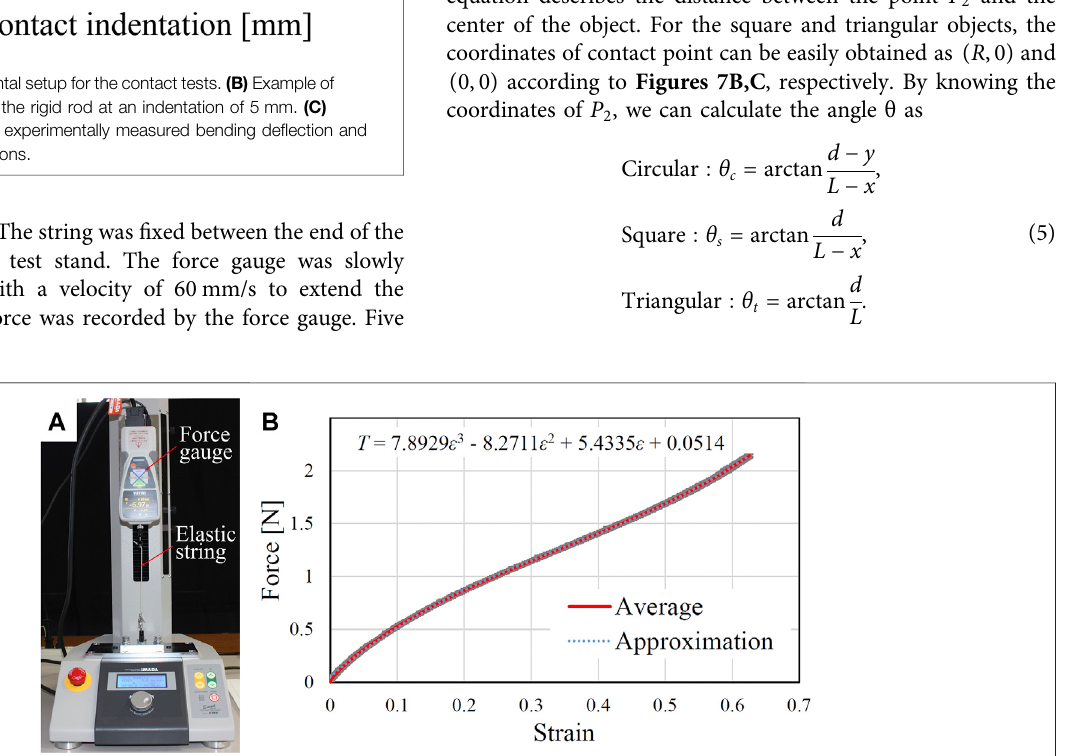
Frontiers in Robotics and AI |